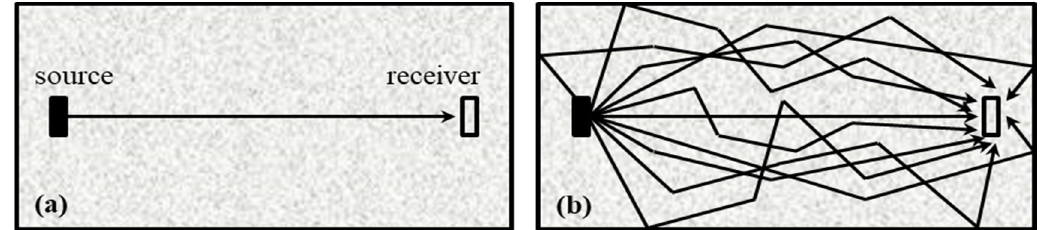
Figure 2. Principle of ultrasonic transmission measurements and propagation paths for ( a ) a direct wave and ( b ) a coda wave.